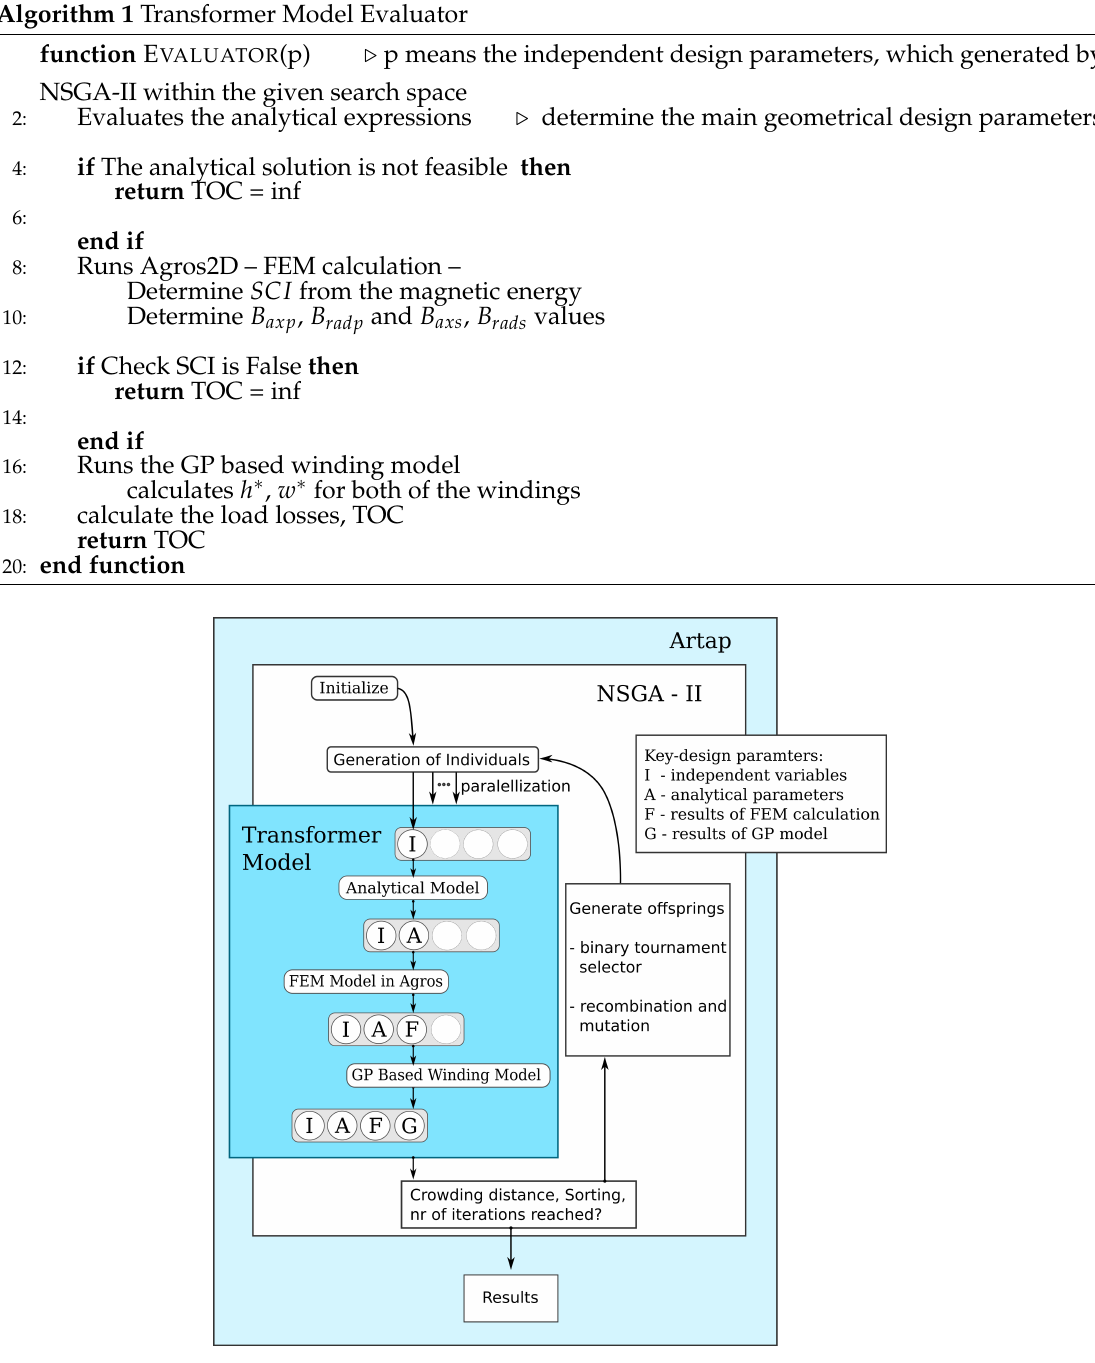
Figure 4. Structure of the realized methodology in the